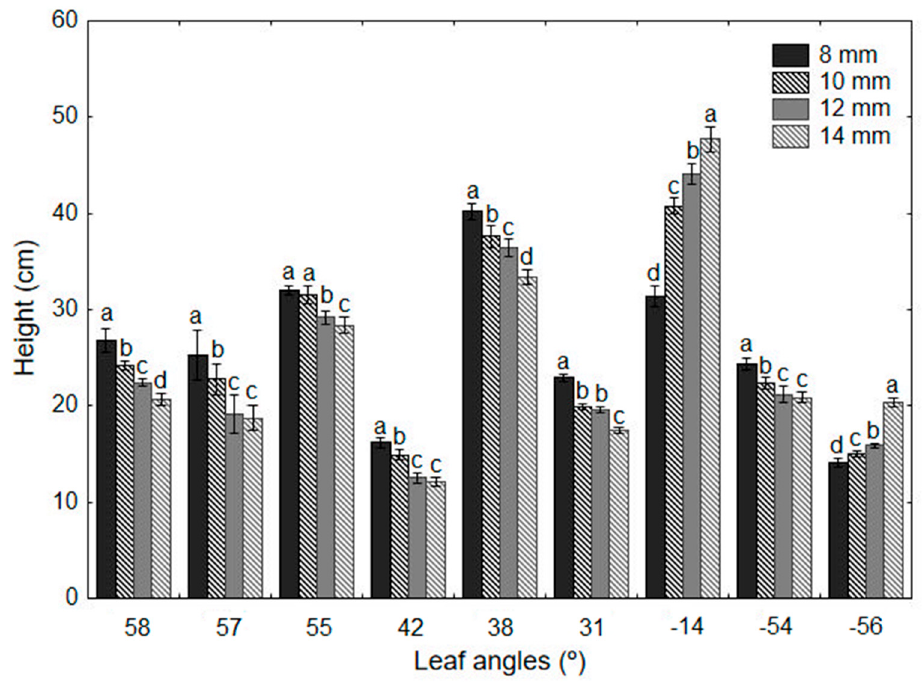
Figure 3. Effect of irrigation volumes for each mean leaf angle on height (cm) of seedlings. For each mean leaf angle, means with the same letter are not significantly different from each other according to Scott–Knott’s test ( p < 0.05). Error bars indicate standard error.